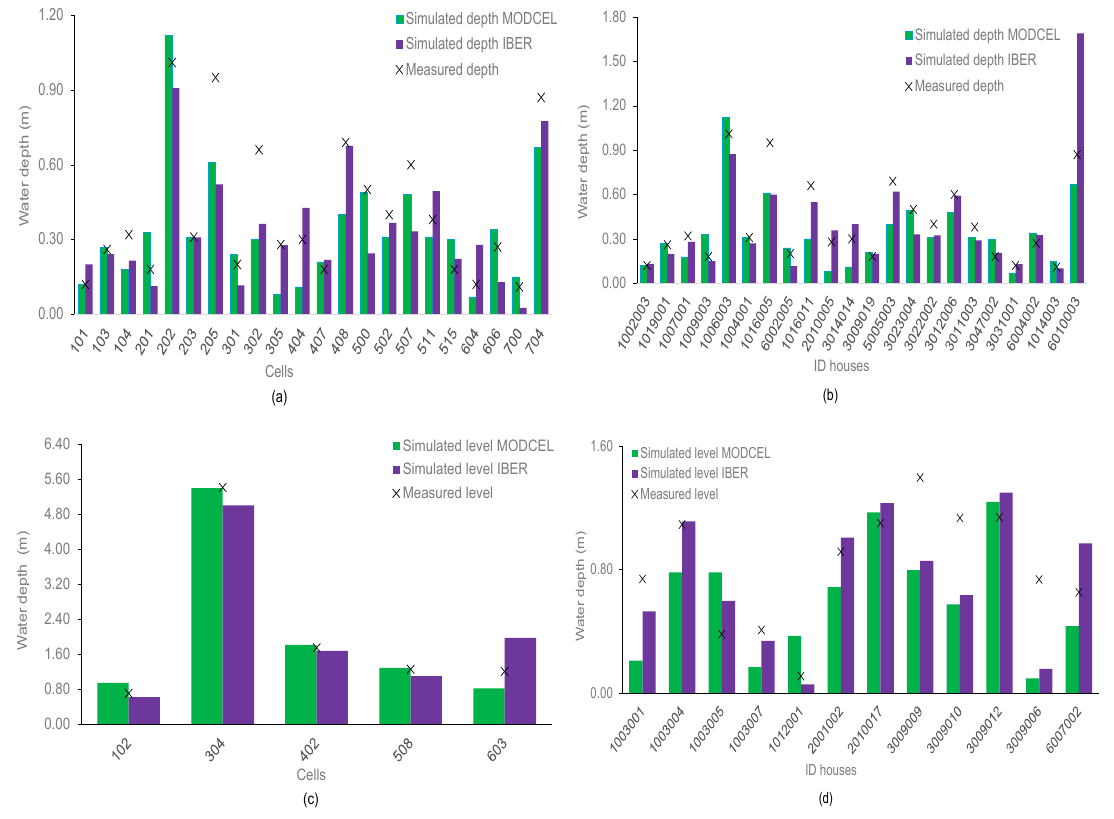
Figure 6. Comparison of water depth determined in the survey and simulated in validation event: ( a ) transport type cells center; ( b ) in the houses located in the transport type cells; ( c ) tank type cells center; ( d ) houses located in the tank type cells. (Numbers in abscissa refer to cells codes) .